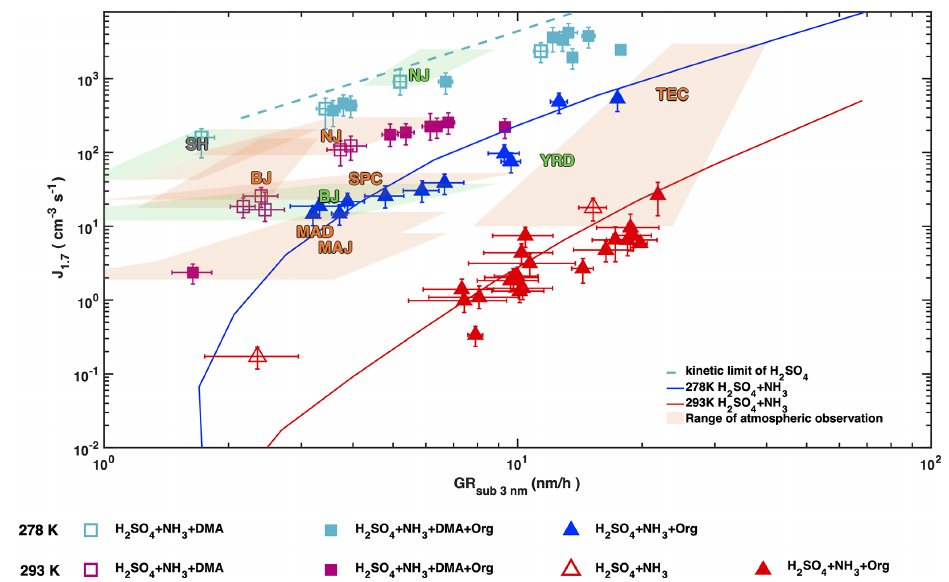
Figure 7. Particle formation rates ( J 1 . 7 ) versus growth rates of sub-3nm particles. CLOUD data were recorded at 278K (blue and cyan symbols) or 293K (red and magenta) with 1 to 2ppbv NH 3 . Experiments without DMA are shown by triangles and experiments with 4pptv DMA by squares. Filled and open symbols indicate presence or absence of organics, respectively. Error bars denote uncertainties of J 1 . 7 and GR values. Solid lines represent the simulated nucleation/growth rates with a kinetic model of sulfuric acid with 1ppbv ammonia at 278K (blue) and 293K (red). H 2 SO 4 nucleation at the kinetic limit is indicated by the cyan dashed line. Also shown are the mean values for sub-3nm GR and sub-2nm J from observations in the polluted boundary layer at the following locations: Shanghai (SH) (Yao et al., 2018), Beijing spring and winter (BJ) (Cai et al., 2017; Jayaratne et al., 2017), Madrid (urban: MAD and suburban: MAJ) (Carnerero et al., 2018), Po Valley regional (San Pietro Capofiume, SPC) (Kontkanen et al., 2017), Nanjing summer and winter (NJ) (Yu et al., 2016), Yangtze River Delta regional (YRD) (Dai et al., 2017), and Tecamac (TEC) (Kuang et al., 2008). The text colours indicate < 288K (green), > 288K (orange) or all year (grey). The shaded area colours indicate the range of ( J , GR) values at these locations for temperatures < 288K (green) and > 288K